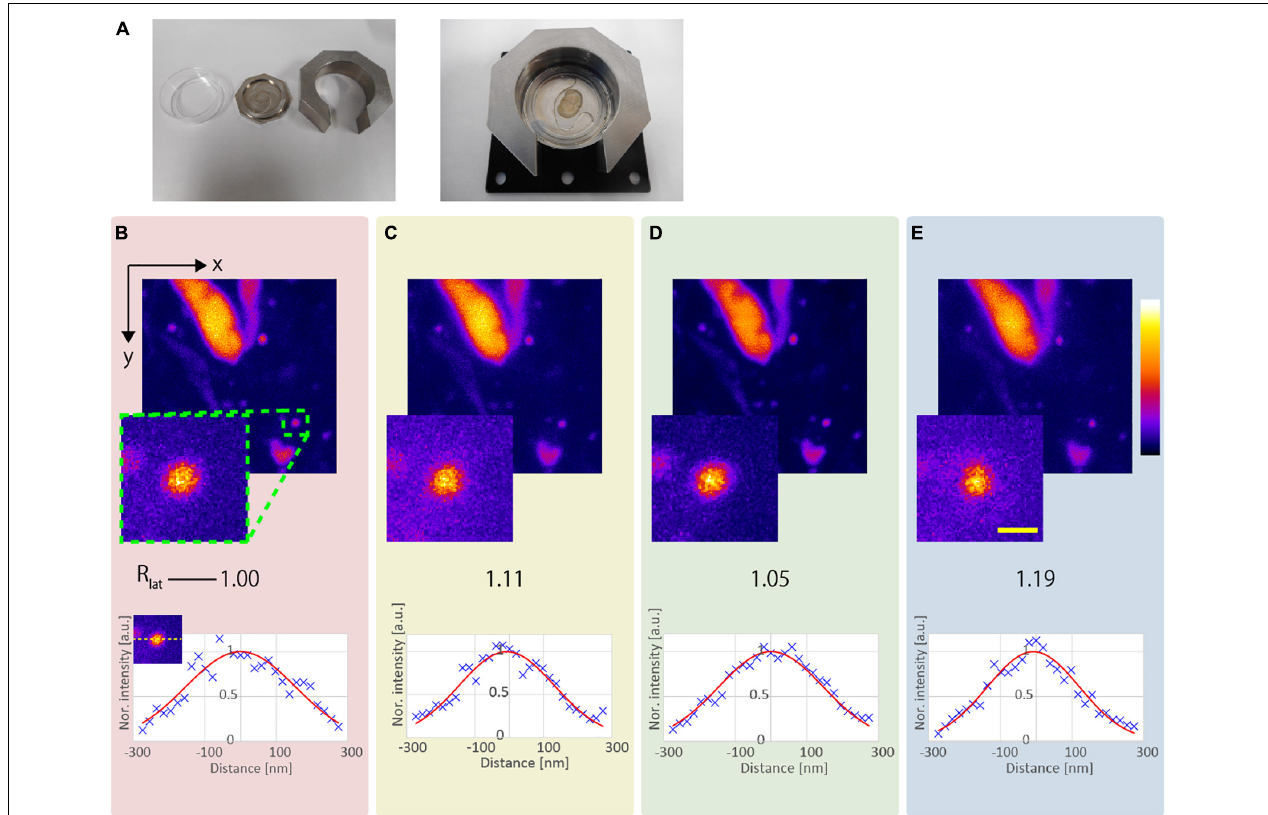
FIGURE 6 | Observation result of the YFP mouse brain near the surface. (A) Photograph of the developed fixing tool. (B) CP, (C) AMCP, (D) APV, and (E) AMAPV excitation beams. Top: x-y stacked images from 0 to 9 µ m optical depth. Bottom: line profile and Gaussian fitting result in the lateral direction. The excitation beam intensity under the objective lens was (B) 17.1, (C) 28.8, (D) 23.8, and (E) 30.3 mW. Scale bar: 500